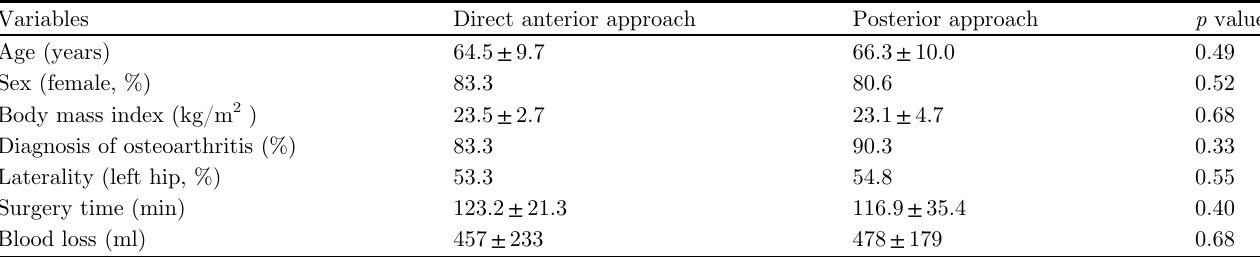
Table 1. Demographic and surgical data.